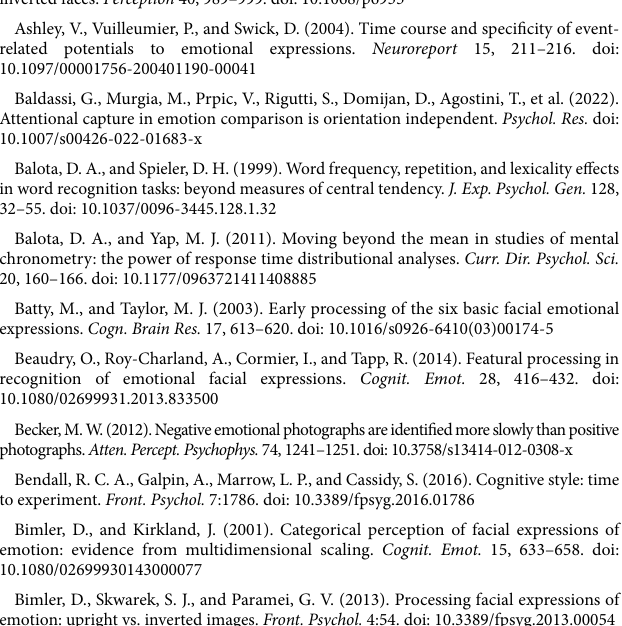
SUPPLEMENTARY FIGURE S1 RT* distributions, Upright and Inverted, for HK (top row), BF (middle row) and SB (bottom row). ( a ) S responses for 15 identical pairs; ( b ) D responses for 10 most-different pairs; ( c ) S responses for 10 intermediate-similarity pairs; ( d ) D responses for 10 intermediate-similarity pairs. SUPPLEMENTARY FIGURE S2 RT*( i,j ) distributions for 15 identical pairs (solid lines) with superimposed ex-Gaussian functions (dotted lines) for three remaining participants (rows), in Upright (left) and Inverted (right) modes of FE